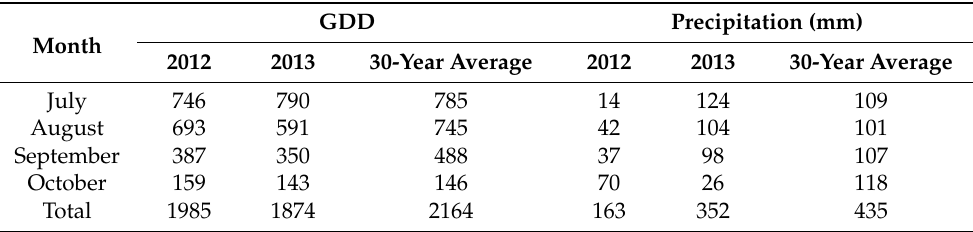
Table 1. Monthly and total growth degree days (GDD 10 ◦ C) and precipitation (mm) in 2012 and 2013 as compared with the 30-yr average data at the University of Massachusetts experimental farm, South